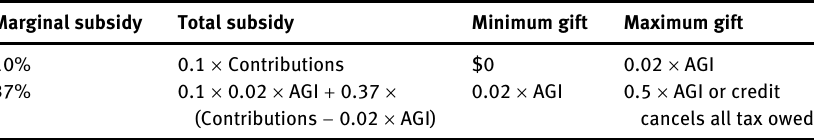
Table  : Subsidy schedule for proposed two-tier charitable giving